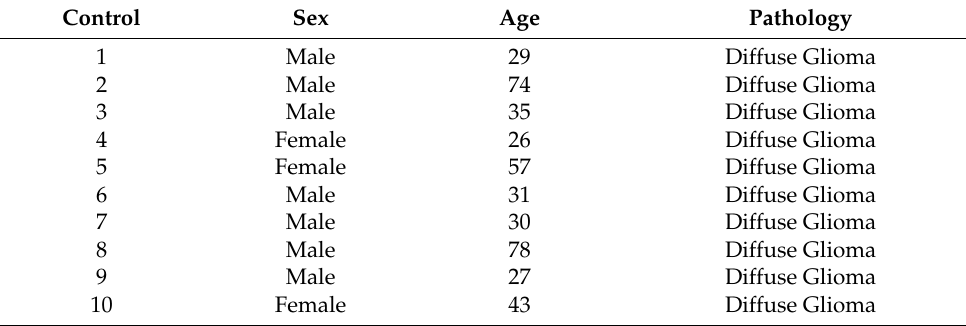
Table 2. Control patients